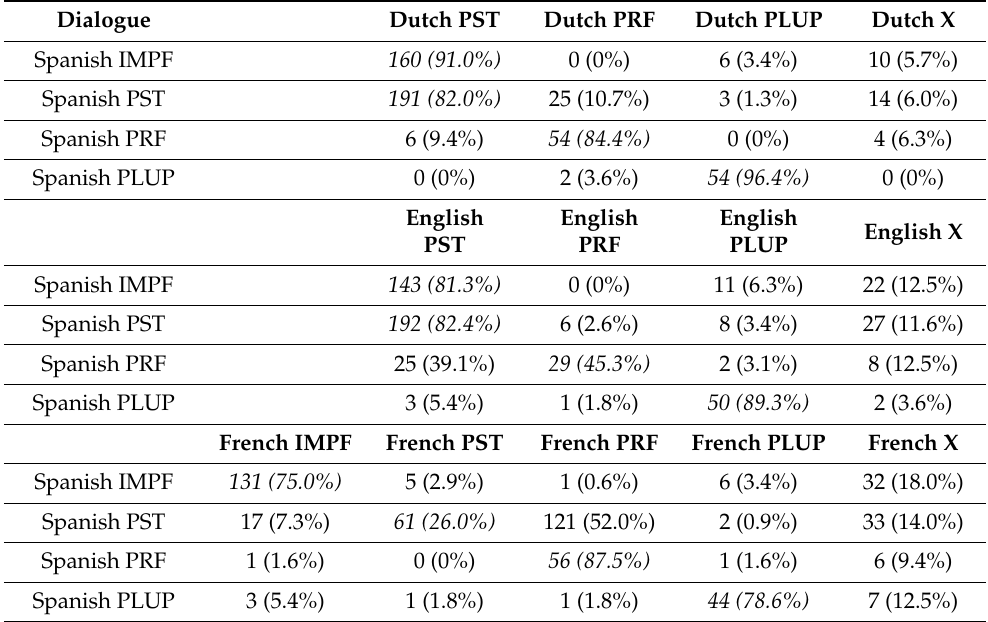
Table 2. Number of Spanish forms (rows) translated to Dutch, English, and French forms (columns) in dialogue, with the relative proportion in % between brackets.